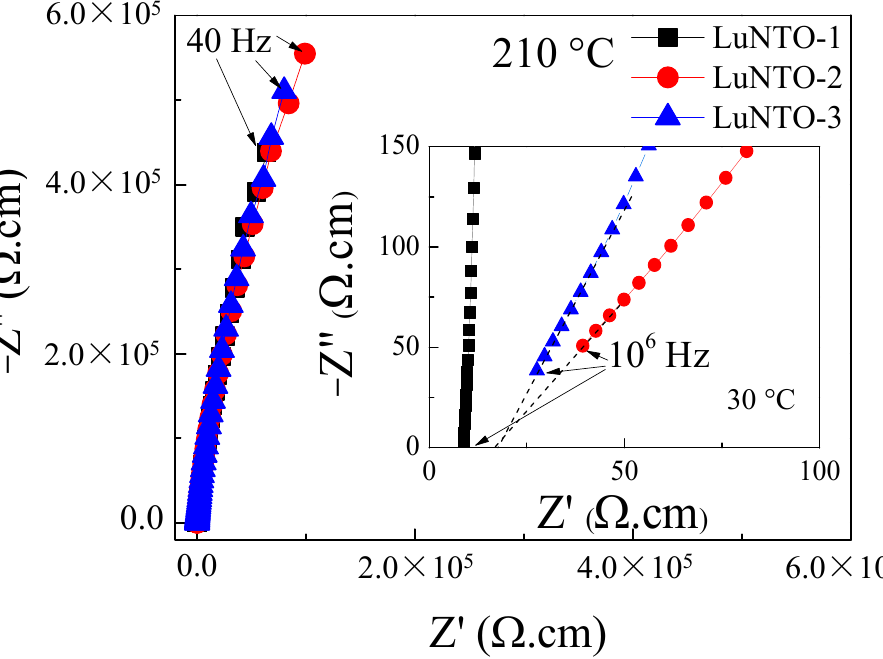
Figure 10. Impedance complex plane (Z*) plots at 200 ◦ C for LuNTO-1, LuNTO-2, and LuNTO-3 ceramics; inset shows the nonzero intercept at high frequencies at 30 ◦ C.